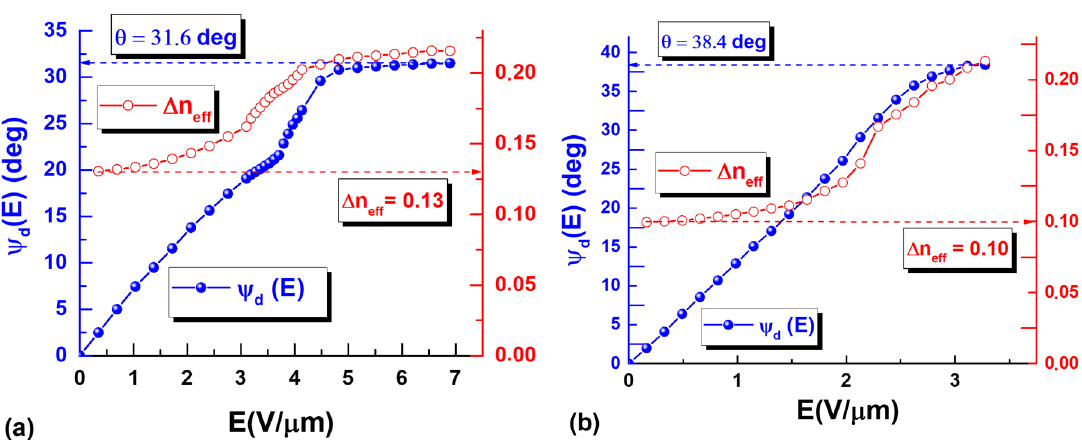
Figure 3. Dependencies of ∆ n e ff ( E ) (red circles) and Ψ d (E) (blue balls) that on the left ( a ) relates to the FLC-587-F7, and on the right ( b ) to the FLC-650. Measurements were carried out at 22 ◦ C, at a wavelength of λ = 632.8 nm.